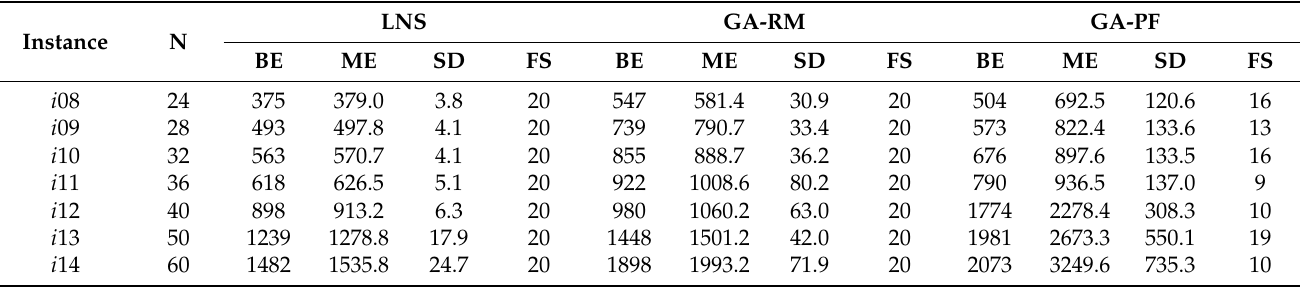
Table 6. The results of LNS algorithm and